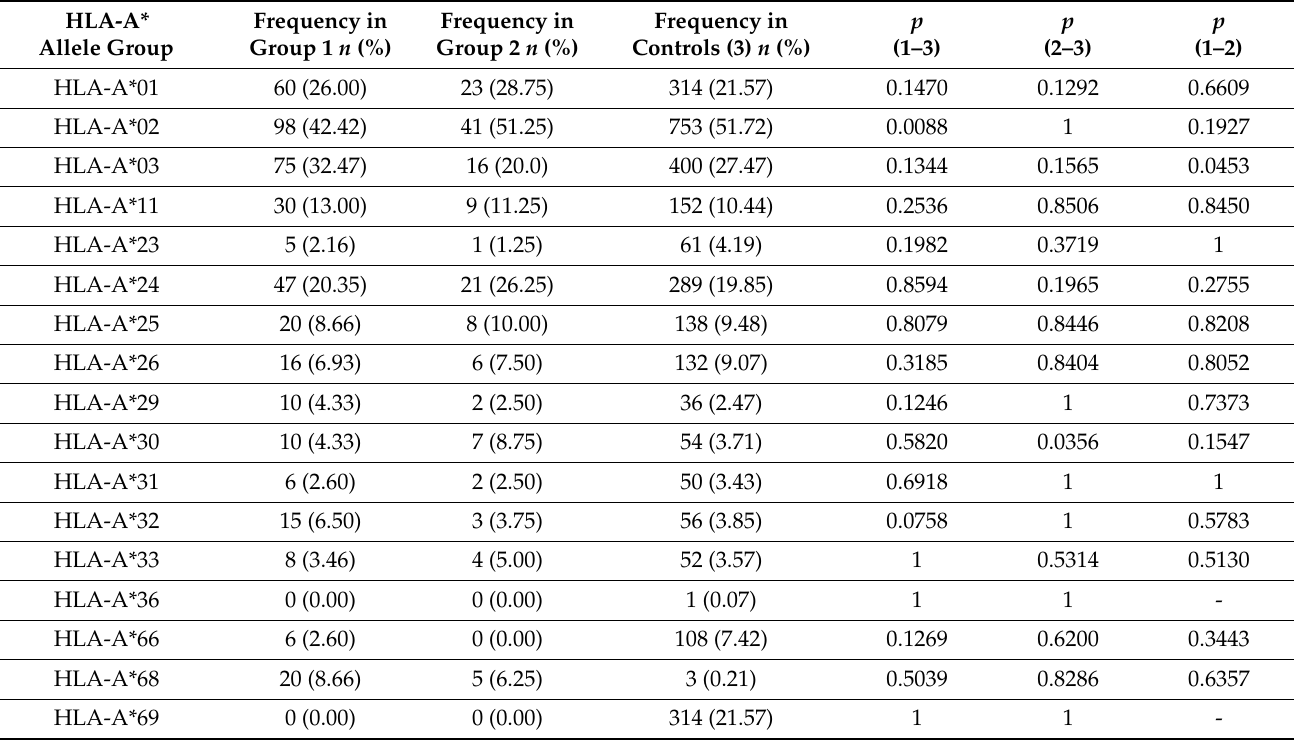
Table 4. Frequency of HLA-A* allele groups in the 1st ( n = 231) and 2nd ( n = 80) COVID-19 convalescent groups compared with controls ( n = 1456).